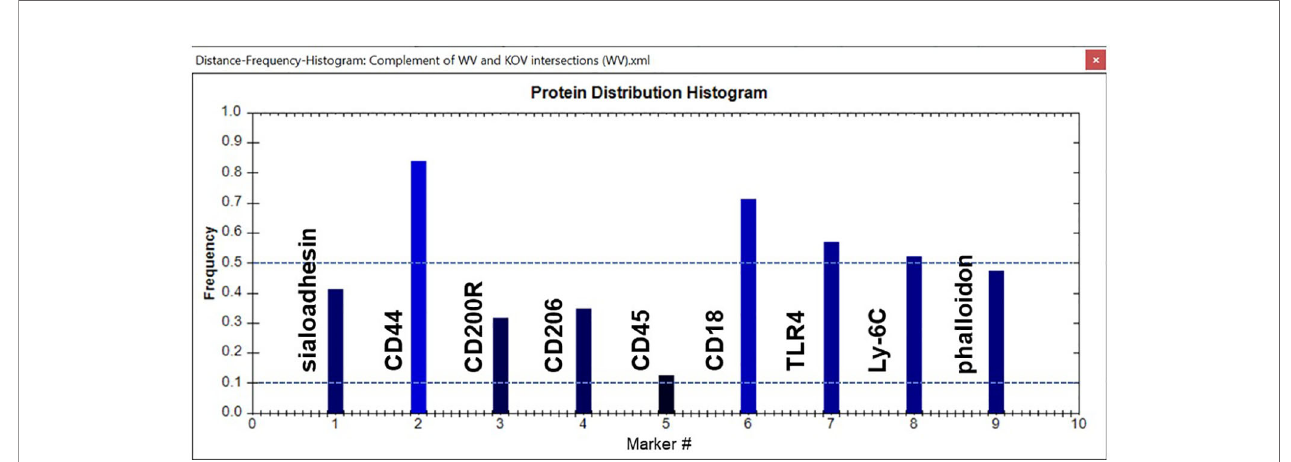
FIGURE 4 | Sample histogram.Anexampleof a CMPhistogram for one of the samples isshown.Reference lines (dotted blue) have been added for frequencies of 0.1 (10%)and 0.5 (50%).The frequency shows the relative abundance of a given marker inthe set of CMPs used to generate the histogram.In this case Marker #2 (CD44) is found in 83% of the CMPs, whereas Marker #4 (CD206)isonly found in12% ofthe graphed CMPs. The names ofthe markersrepresented byeach bar are shown.